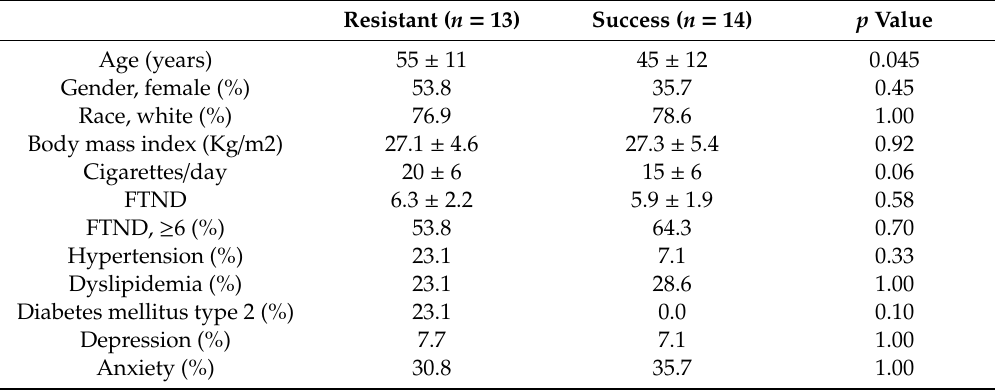
Table 1. Clinical and demographic characteristics of patients treated with varenicline according to the treatment